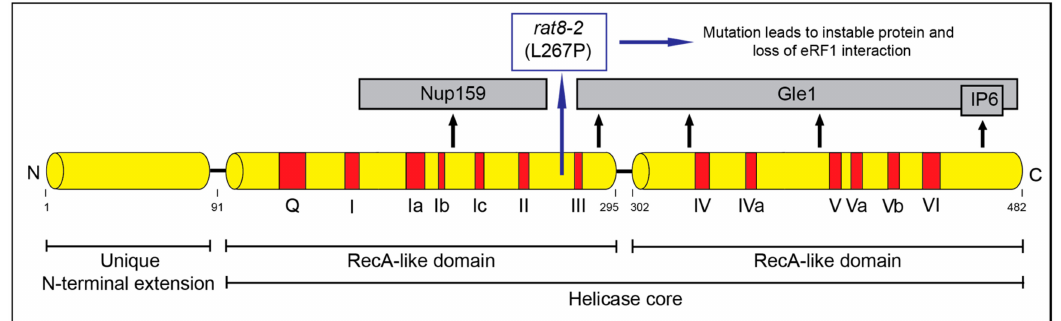
Figure 1. Scheme of the domain structure of Dbp5. Indicated are the domains important for RNA- and ATP binding (red) and the domains important for the interaction partners and co-factors